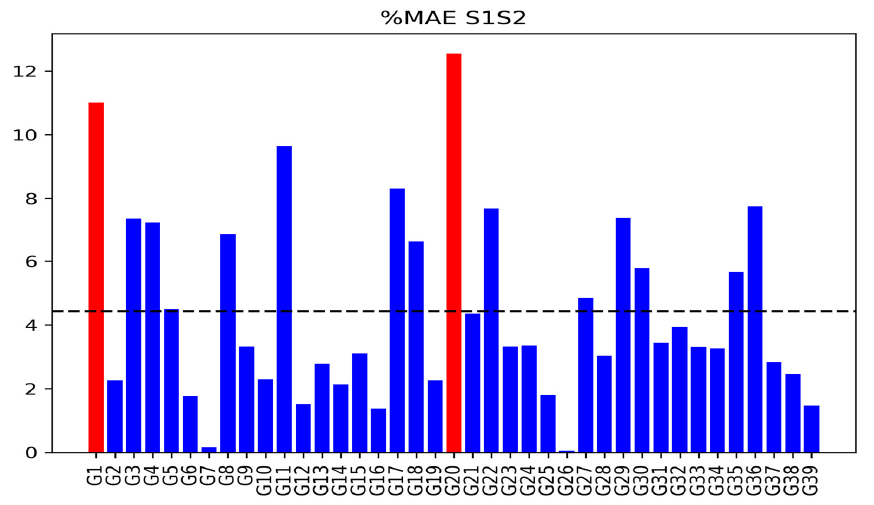
Figure 9. %MAE of the 39 plots when yield was predicted using the information from the rest of the plots. Those plots where %MAE is higher than 10% are shown in red. The dashed black line represents the mean %MAE.